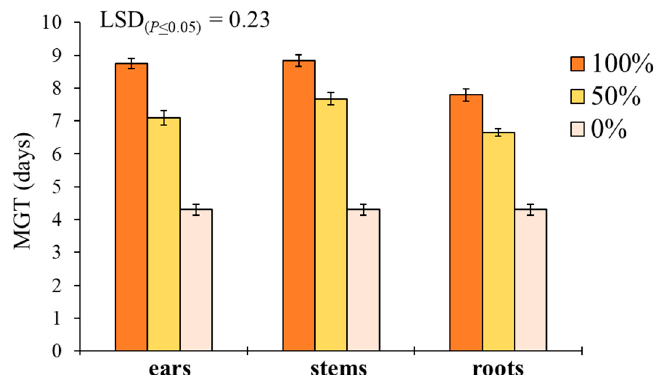
Figure 4. Effect of durum wheat ‘plant part × extract dilution’ interaction on Stellaria media mean germination time (MGT, days). Least Significant Difference (LSD) interaction was calculated with the LSD test at p < 0.05. Bars indicate ± standard error.